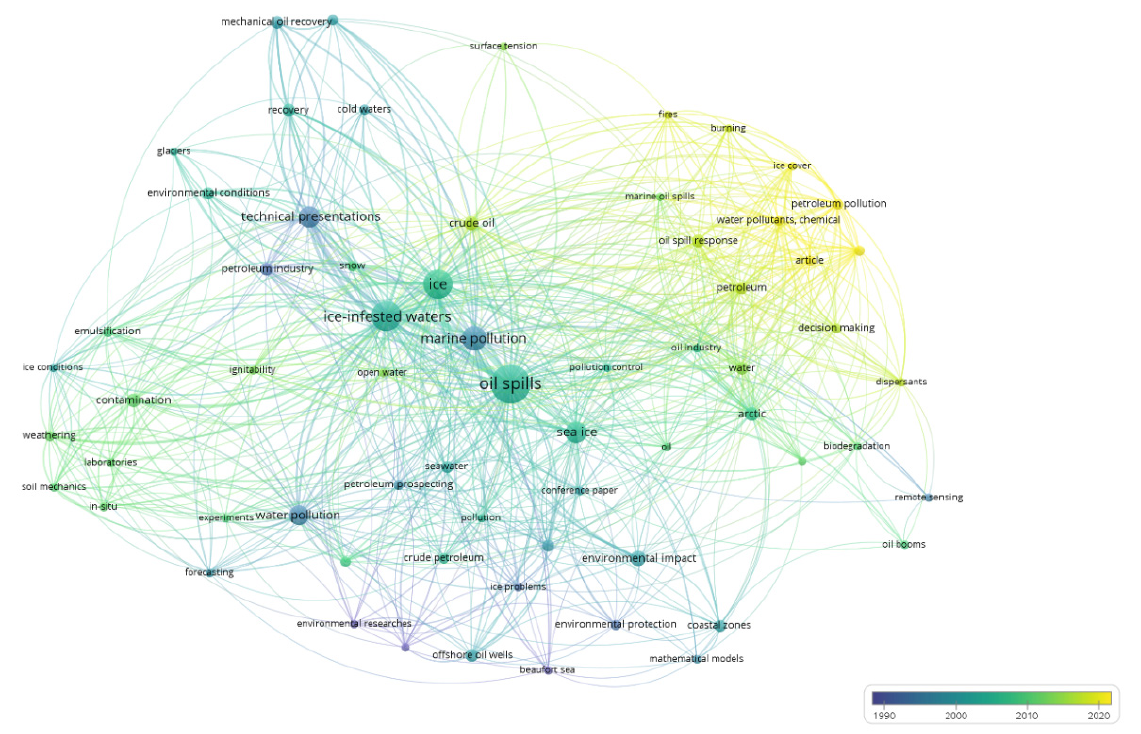
Figure 7. Analysis of terms in oil spills publications in ice ‐ infested waters with time information.